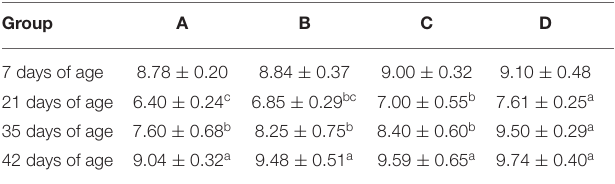
TABLE 5 | Serum H9N2 AIV antibody levels of yellow-feathered chickens in different treatment groups. Group